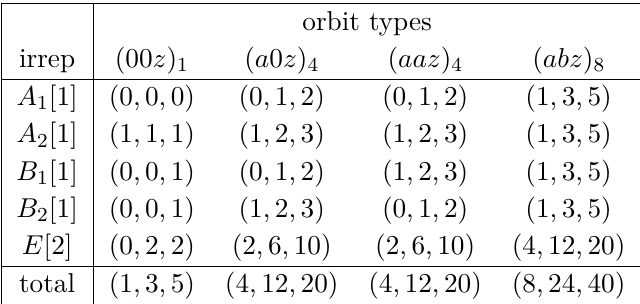
Table 11. As for table 10 but for frames with d ref = (0 , 0 , n ) . See table 5 for orbit-type composi- tions.